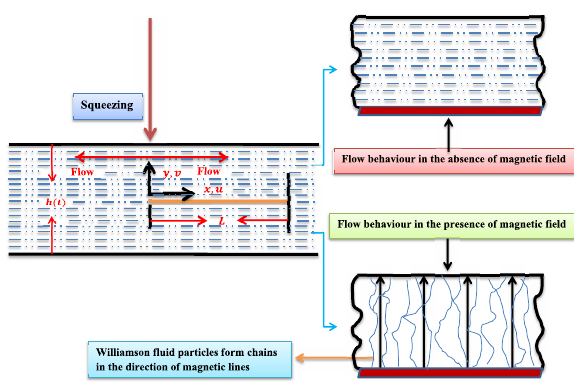
Figure 1: Physical configuration of the present problem